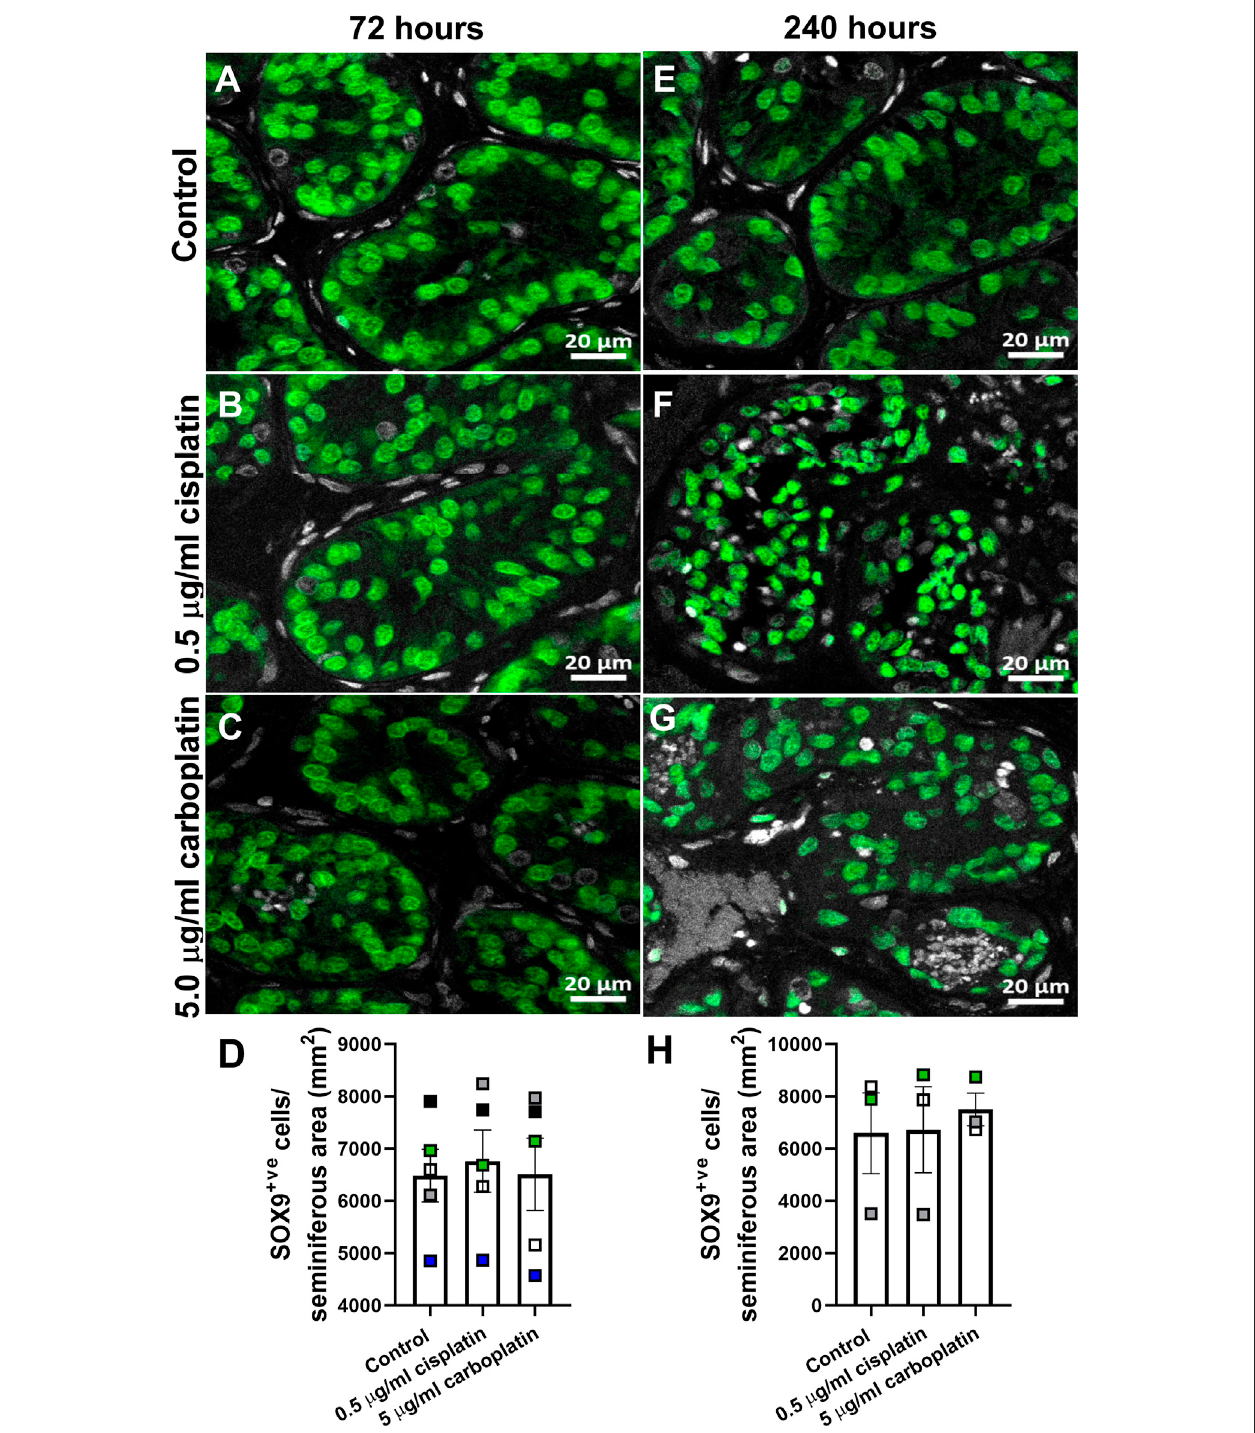
FIGURE 7 | Effects of exposure to cisplatin and carboplatin on Sertoli cell number in the human pre-pubertal testicular tissues. SOX9 (green) protein expression in the human pre-pubertal testicular tissues 72 h (A – C) and 240 h (E – G) following exposure to vehicle control, cisplatin (0.5 μ g/ml) or carboplatin (5 μ g/ml). Scale bars represent 20 μ m. Quanti fi cation of Sertoli cell (SOX9 +ve ) numbers per tubular area (mm 2 ) in the human pre-pubertal testicular tissues 72 h (D) and 240 h (H) following exposuretovehiclecontrol,cisplatin(0.5 μ g/ml)orcarboplatin(5 μ g/ml).ExposuretocisplatinorcarboplatinhadnoeffectontheSertolicellnumbersinhumanpre- pubertal testicular tissues at either 72or 240 h post-exposureDataanalysedusing two-wayANOVA. Dataanalysed using two-way ANOVA. Values shown aremeans ± SEM and each set of coloured data points (black — 2 years, grey and green — 4 years, white — 7 years and blue — 8 years old) represents an individual patient ( n = 3 – 5).